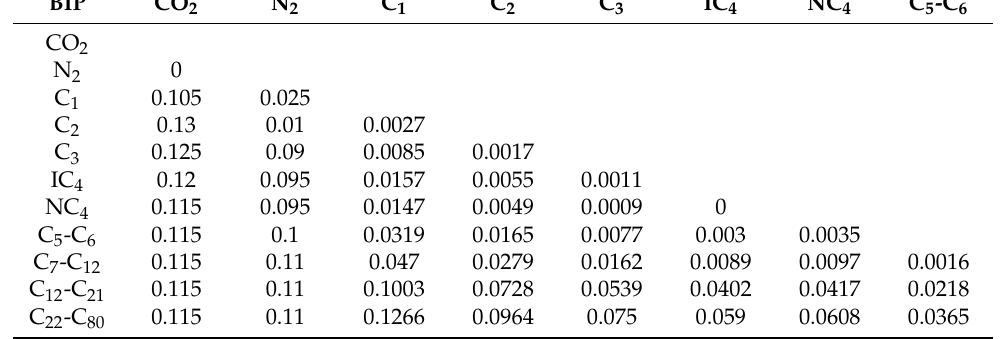
Table 4. Binary interaction parameters of the reservoir hydrocarbon fluid [38].